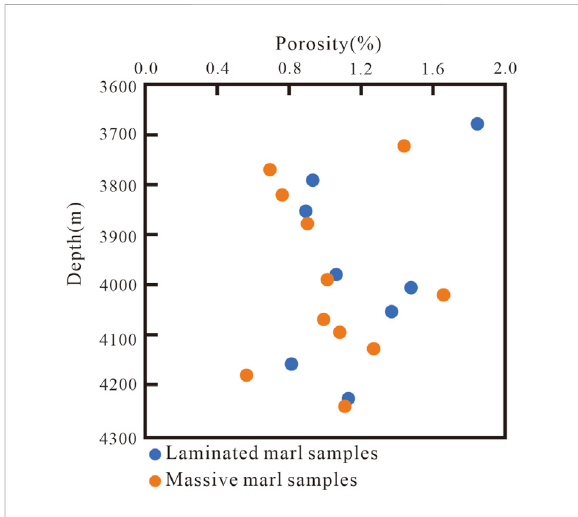
FIGURE 12 Relationship between depth and total porosity of the marl samples from the ST1, Shulu